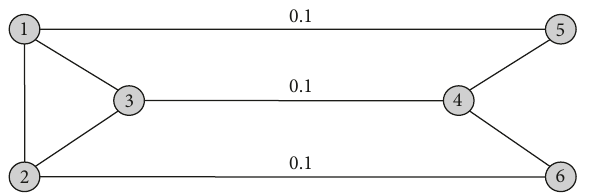
Figure 1: Instance with group consensus. Default edge weight is